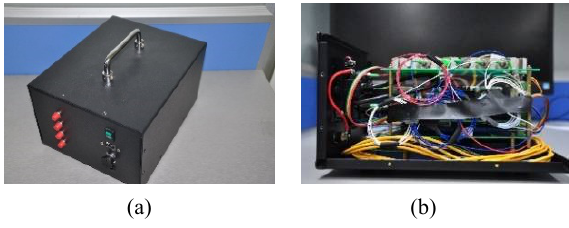
Fig. 7 FBG interrogation system: (a) external structure of the system and (b) internal structure of the system.